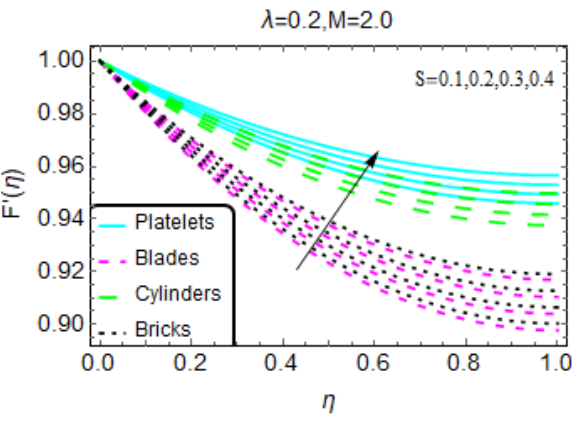
Figure 3. The velocity pattern for different values of S.